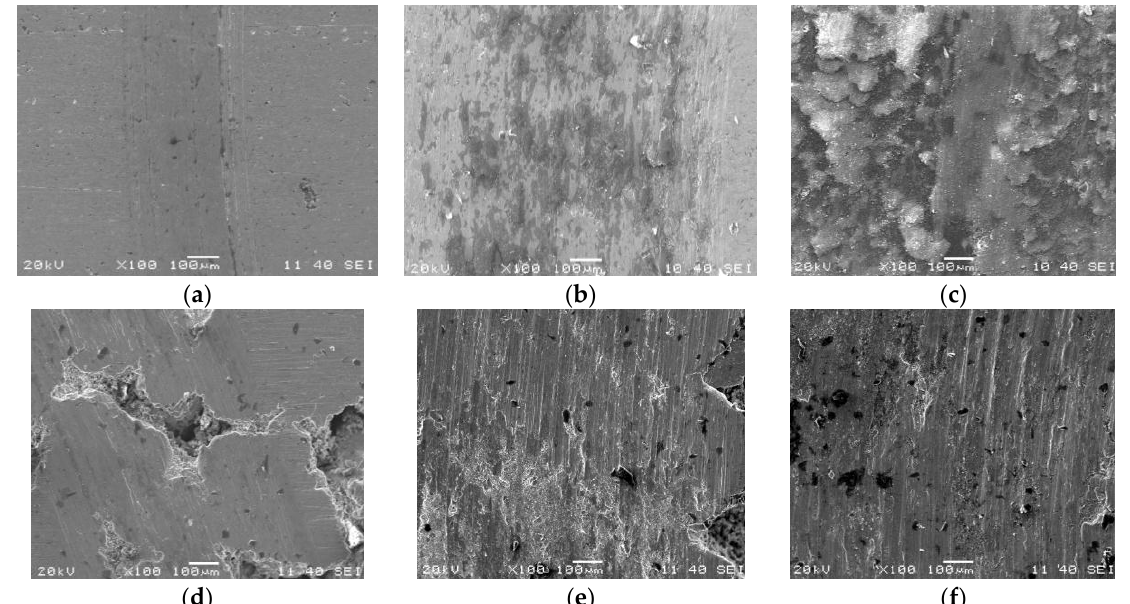
Figure 12. Two groups of SEM images showing the surface morphology of the samples with different loads: ( a ) the porosity of the sample is ~24%–26% and the load is 4 N; ( b ) the porosity of the sample is ~24%–26% and the load is 10 N; ( c ) the porosity of the sample is ~24%–26% and the load is 14 N; ( d ) the porosity of the sample is ~38%–42% and the load is 4 N; ( e ) the porosity of the sample is ~38%–42% and the load is 10 N; and ( f ) the porosity of the sample is ~38%–42% and the load is 14 N.